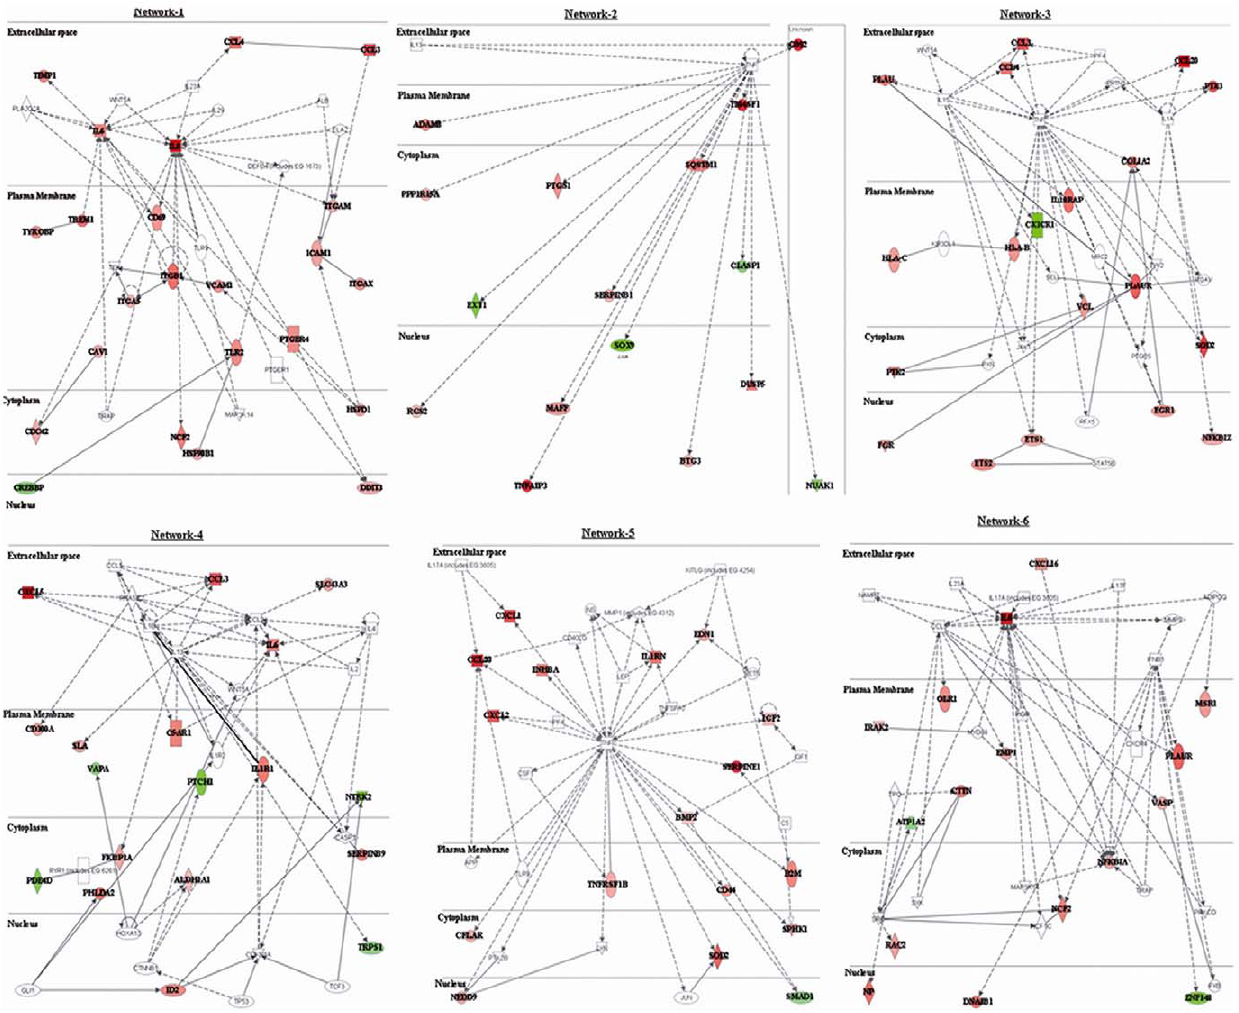
Figure 2. Most relevant molecular networks of interacting genes. The intensity of genes (node) color in the networks indicates the degree of downregulation (green) or upregulation (red) of gene expression; continuous lines indicate a direct interaction and dashed line an indirect interaction.